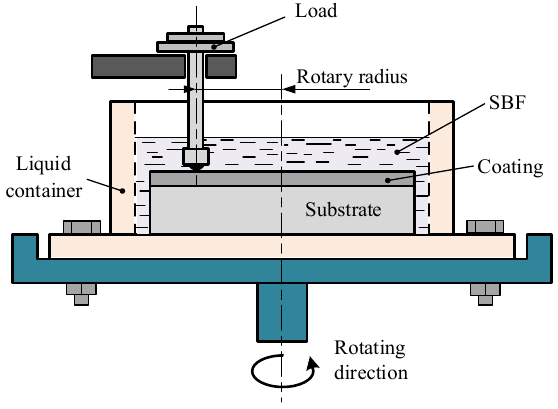
Figure 2. Schematic illustration of the wear tests for the coatings. Table 4. The experimental parameters of the wear tests.